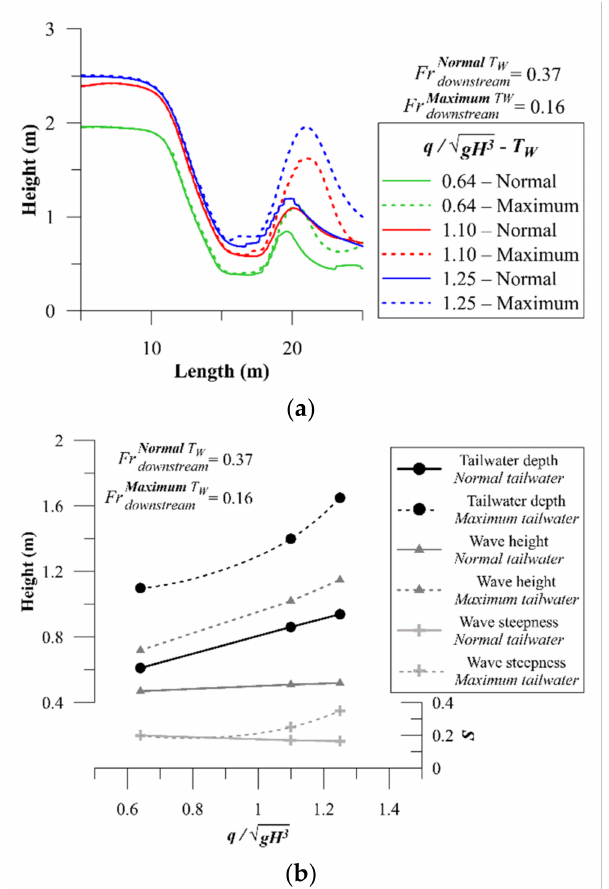
Figure 8. Sensitivity of the surf wave to tailwater depth at different flowrates: ( a ) effect of tailwater depth on wave profile, ( b ) tailwater depth, wave height and steepness versus flowrate.